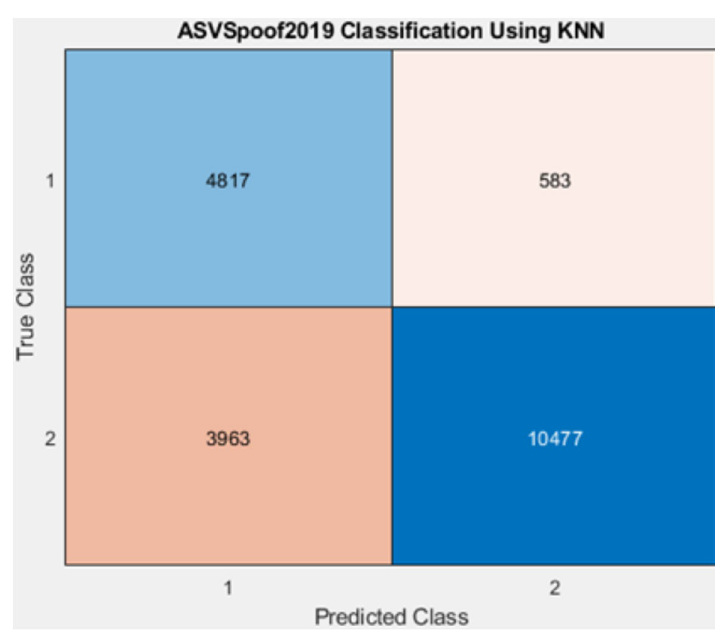
Fig. 14 Confusion Matrix of KNN classifier for voice replay